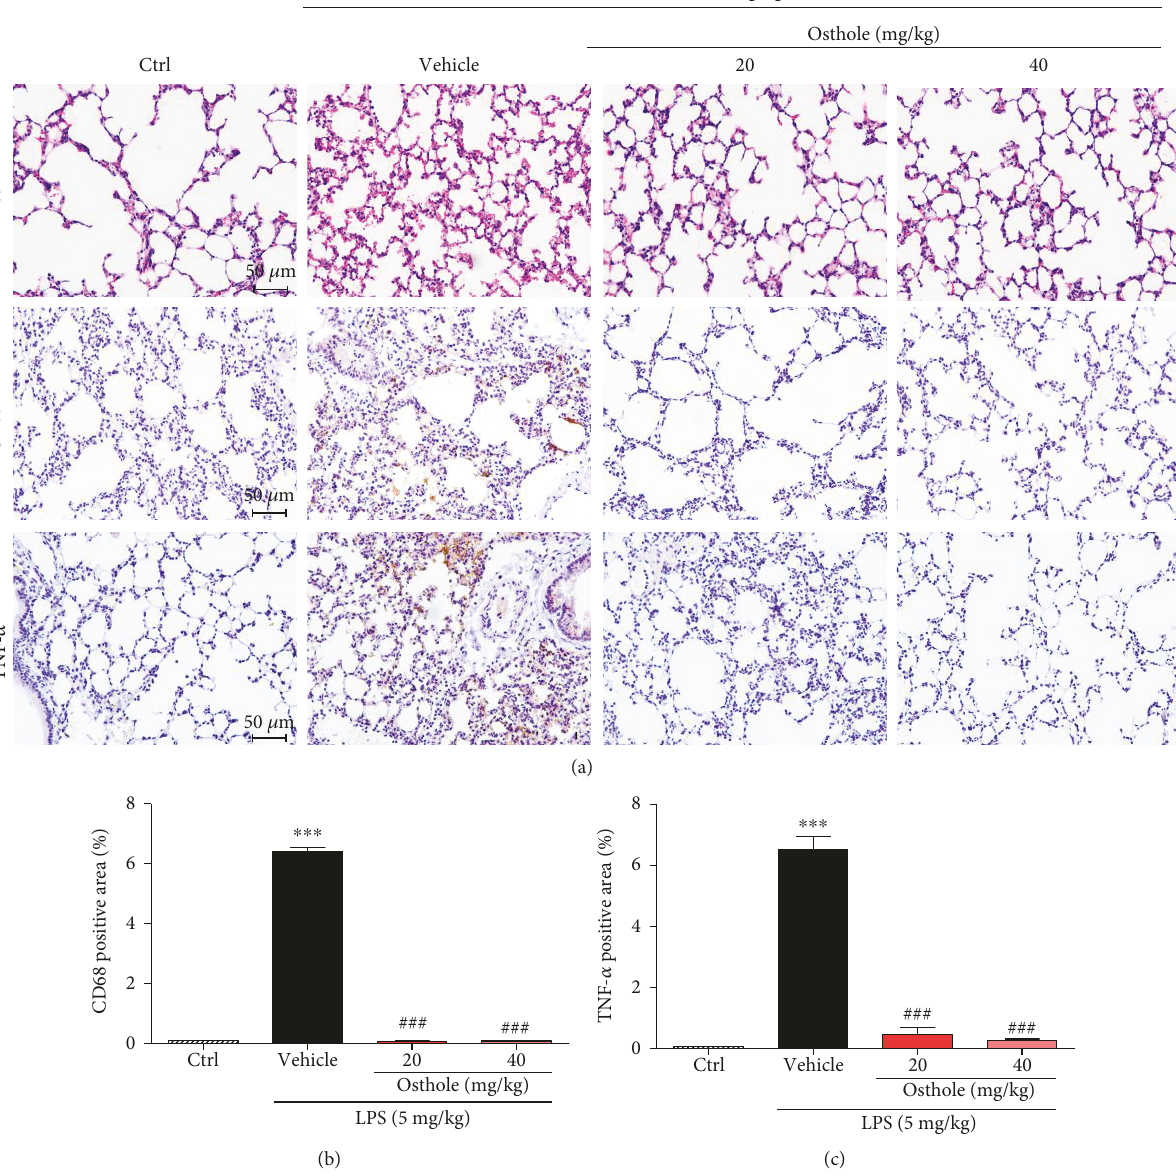
Figure 4: Osthole protects against in fl ammatory tissue injury in LPS-induced ALI. C57BL/6 mice were pretreated for 0.5h with 20mg/kg or 40mg/kg osthole via ip injection, followed by intratracheal injection of 5mg/kg LPS, and lungs were sampled 6h later for analyses. (a, top panel) Representative light micrograph of lung histological changes stained with H&E, (a, middle panel) of immunolocalization of CD68, marker for macrophages (brown), and (a, bottom panel) of tissue localization of TNF- α (brown), micron bar = 50 μ m . Quanti fi cation of positive lung tissue staining for (b) CD68 and (c) TNF- α in (a); values are reported as % mean ± SEM ; n = 4 . ∗∗∗ p < 0 001 versus control (Ctrl). ### p < 0 001 versus